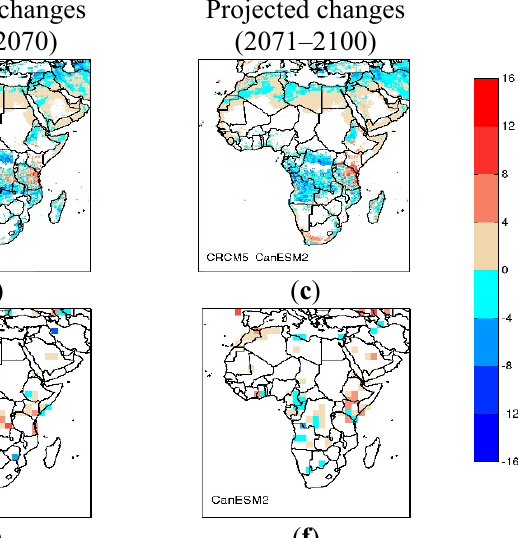
Figure 11. Same as Figure 6, but for the mean number of dry spells for austral